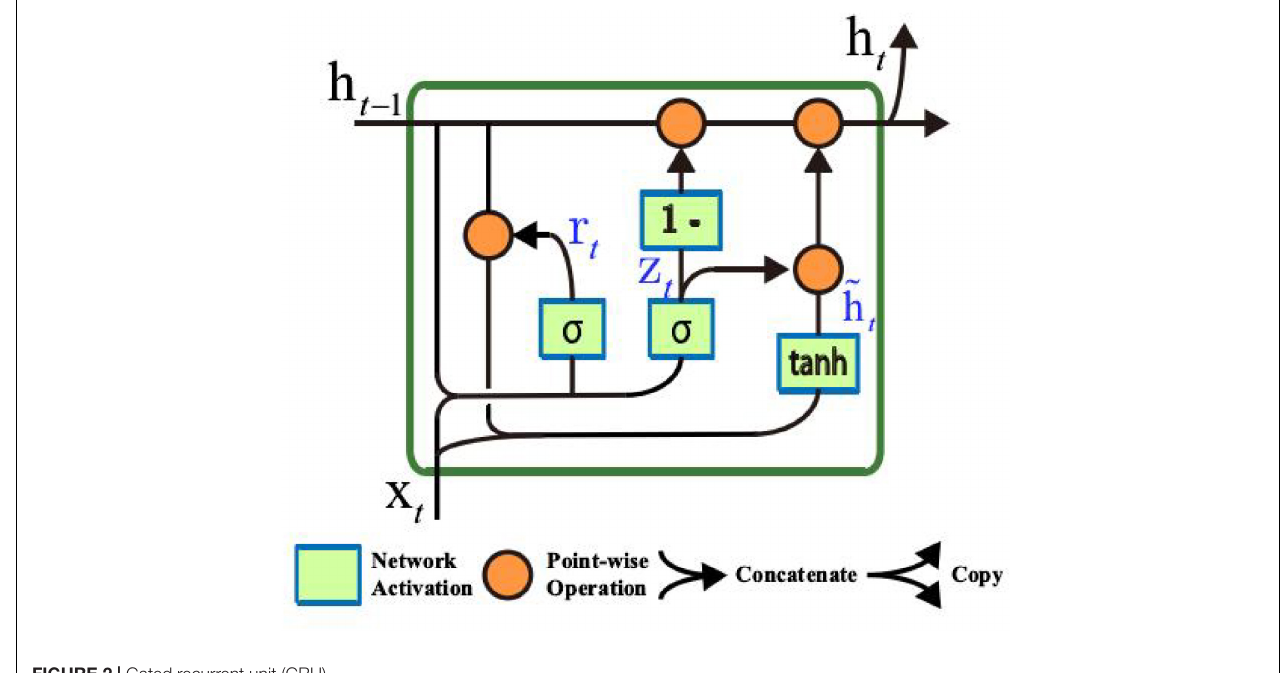
FIGURE 2 | Gated recurrent unit (GRU).